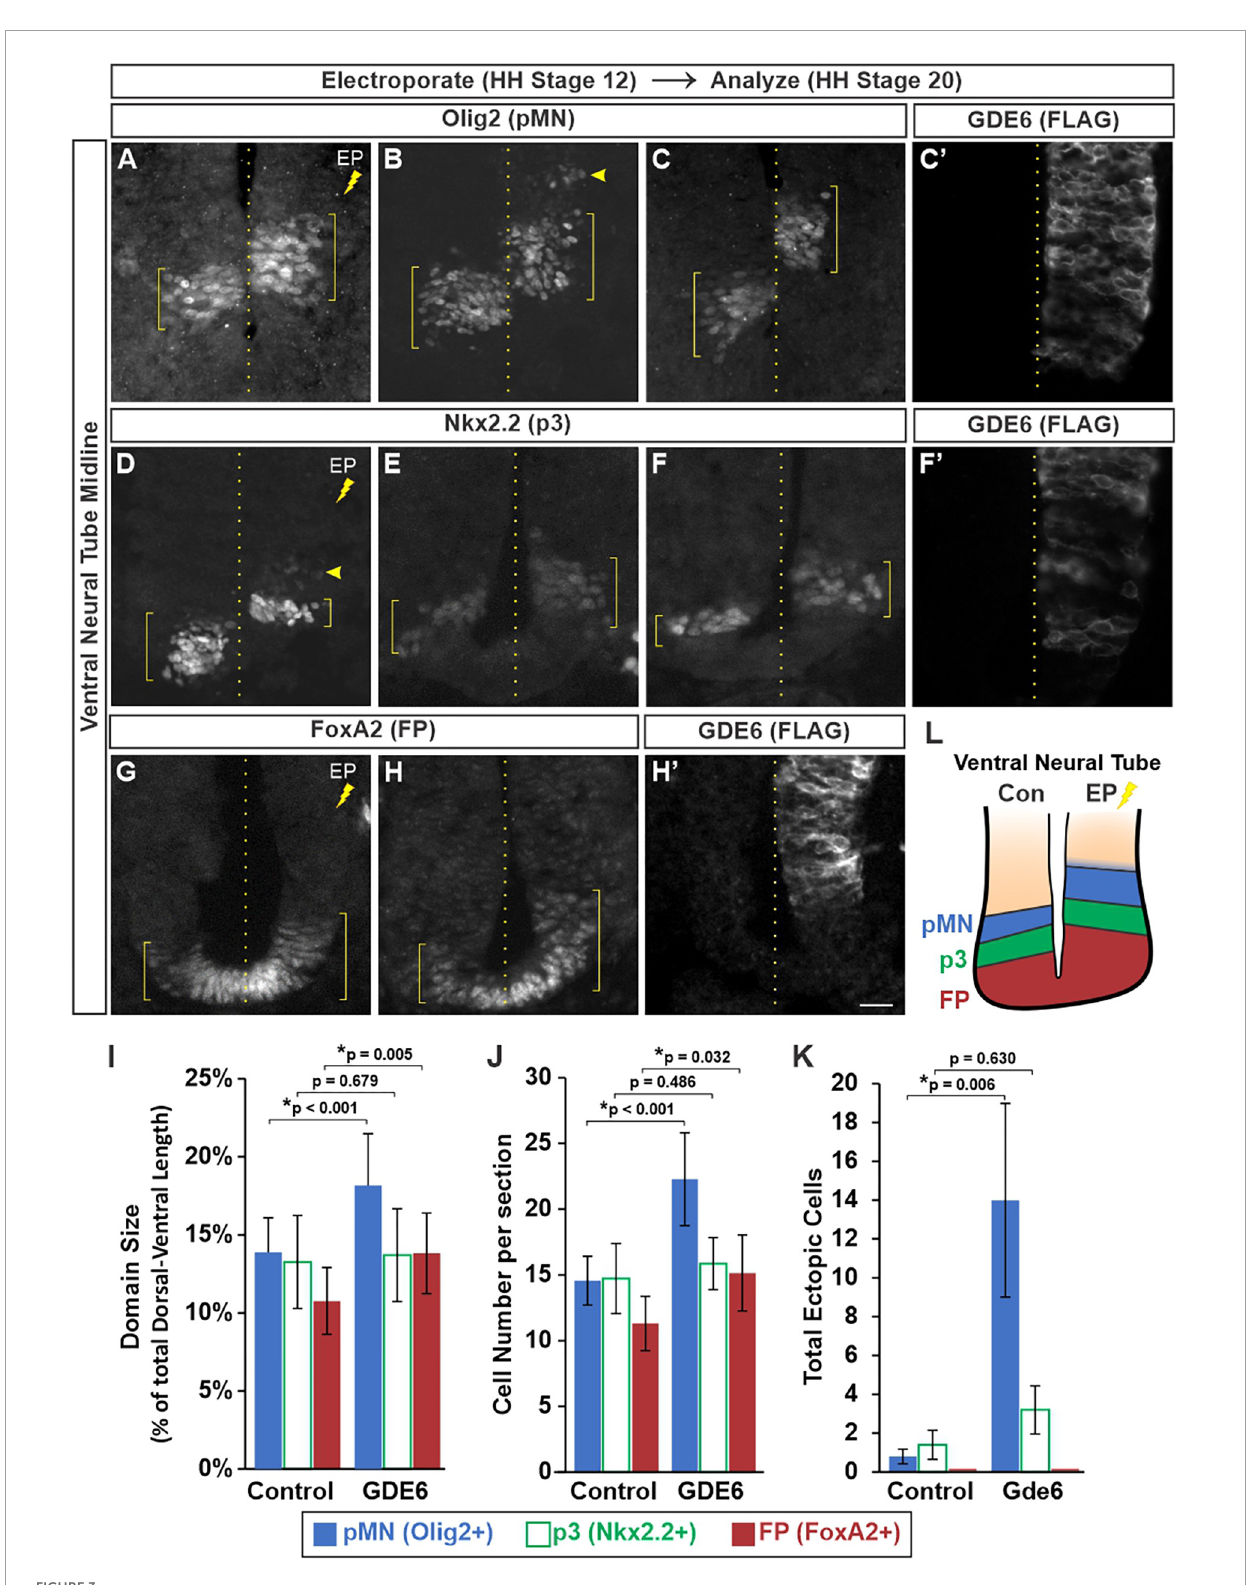
FIGURE3 GDE6 regulates dorsal-ventral progenitor patterning. (A–H’) Transverse sections of stage 20 ventral neural tube electroporated at stage 12 with GDE6. Immunostaining for Olig2 (A–C) , Nkx2.2 (D–F) , and FoxA2 (G,H) visualize the pMN, p3 and floor plate, respectively. Each panel is a different embryo. (C’,F’,H’) Show adjacent sections stained for FLAG to visualize the extent of the electroporation for panels (C,F,H) . Brackets denote the dorsal-ventral extent of the progenitor domains, dotted line indicates the midline, and arrowheads highlight ectopic cells. (I) Quantification of the dorsal-ventral size of each patterning domain. One way ANOVA with repeated measures, * p < 0.001, n = 12. (J) Graph quantifying the mean number of cells per section in each domain. One way ANOVA with repeated measures, * p < 0.001, n = 12. (K) Quantification of the total number of ectopic cells detected outside of their respective domains. One way ANOVA with repeated measures, * p = 0.018, n = 8. No ectopic floor plate cells were detected. (L) Summary of the expanded ventral patterning domains following electroporation of GDE6. Error bars represent S.E.M. Post-hoc pairwise comparisons based on the estimated marginal means are displayed in the graphs. Scale bar (A–H) = 10 µ